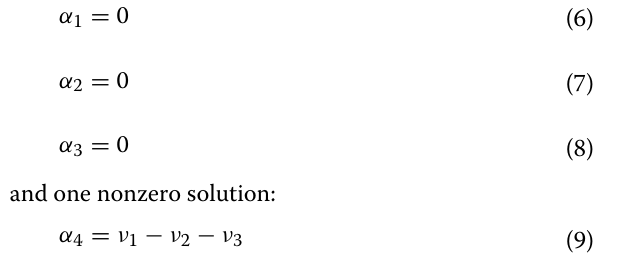
Table 1 Coefficients of the SIRD model of the monkey pox pandemic for Brazil, Canada, Nigeria, the United Arab